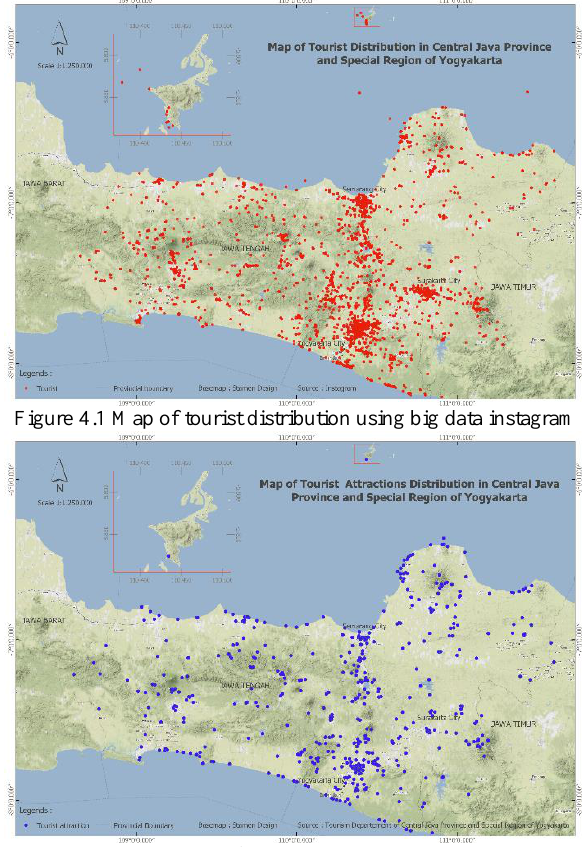
Figure 4.2 Map of tourist attractions distribution